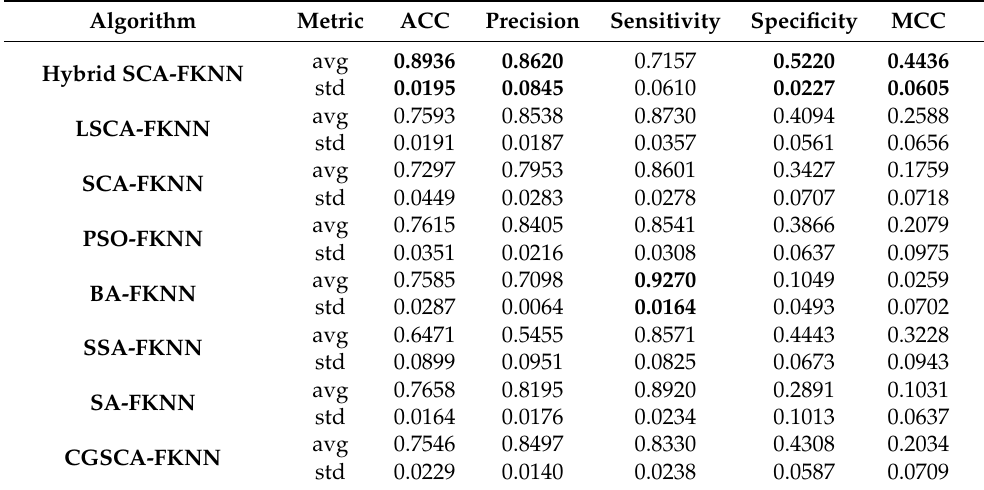
Table 6. Results of the hybrid-FKNN and comparison models on the SPECT dataset. (Bold indicates the best in comparison method).